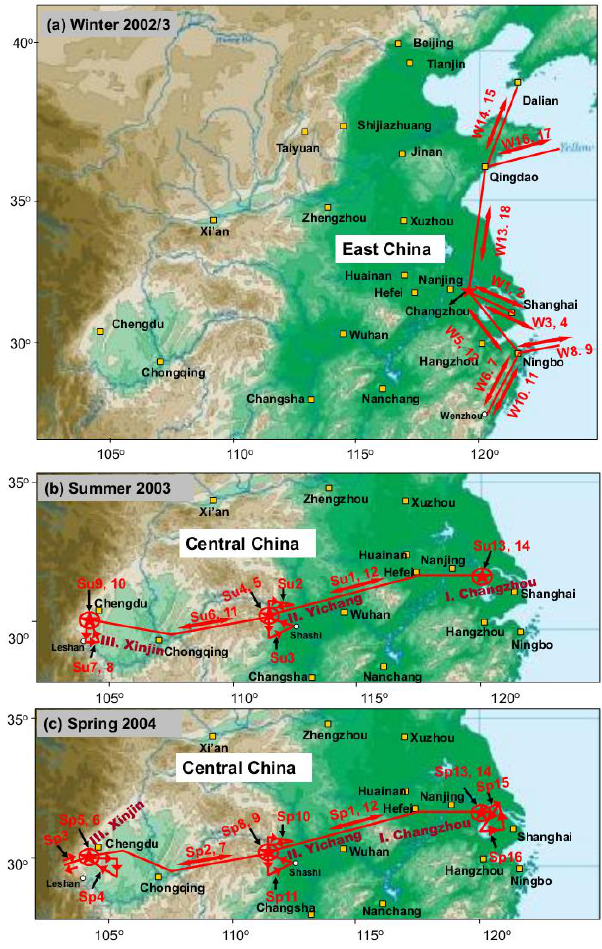
Figure 1. Tracks of research flights during aircraft measurements over China during (a) winter 2002, (b) summer 2003 and (c) spring 2004. The detailed sampling information with flight no. is listed in Table S1 in the Supplement. The maps with the flight tracks were drawn with the software of PowerPoint 2010,